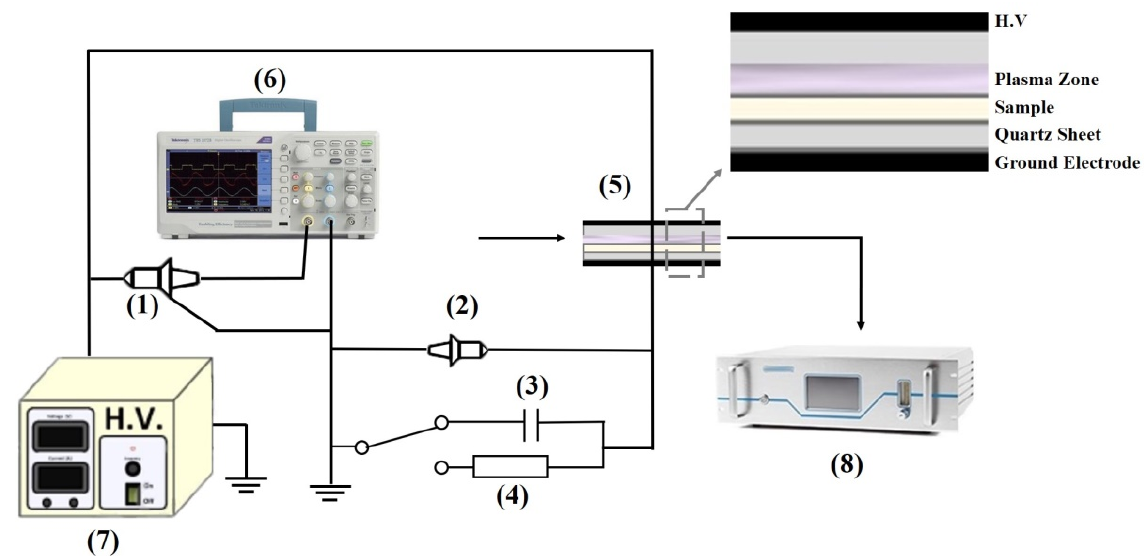
Figure 1. Circuit schematic diagram of electrical parameter measurements in plasma. (1) H.V. probe, (2) passive probe, (3) capacitance, (4) resistance, (5) reactor, (6) oscilloscope, (7) AC high-voltage, (8) -CO x analyzer.